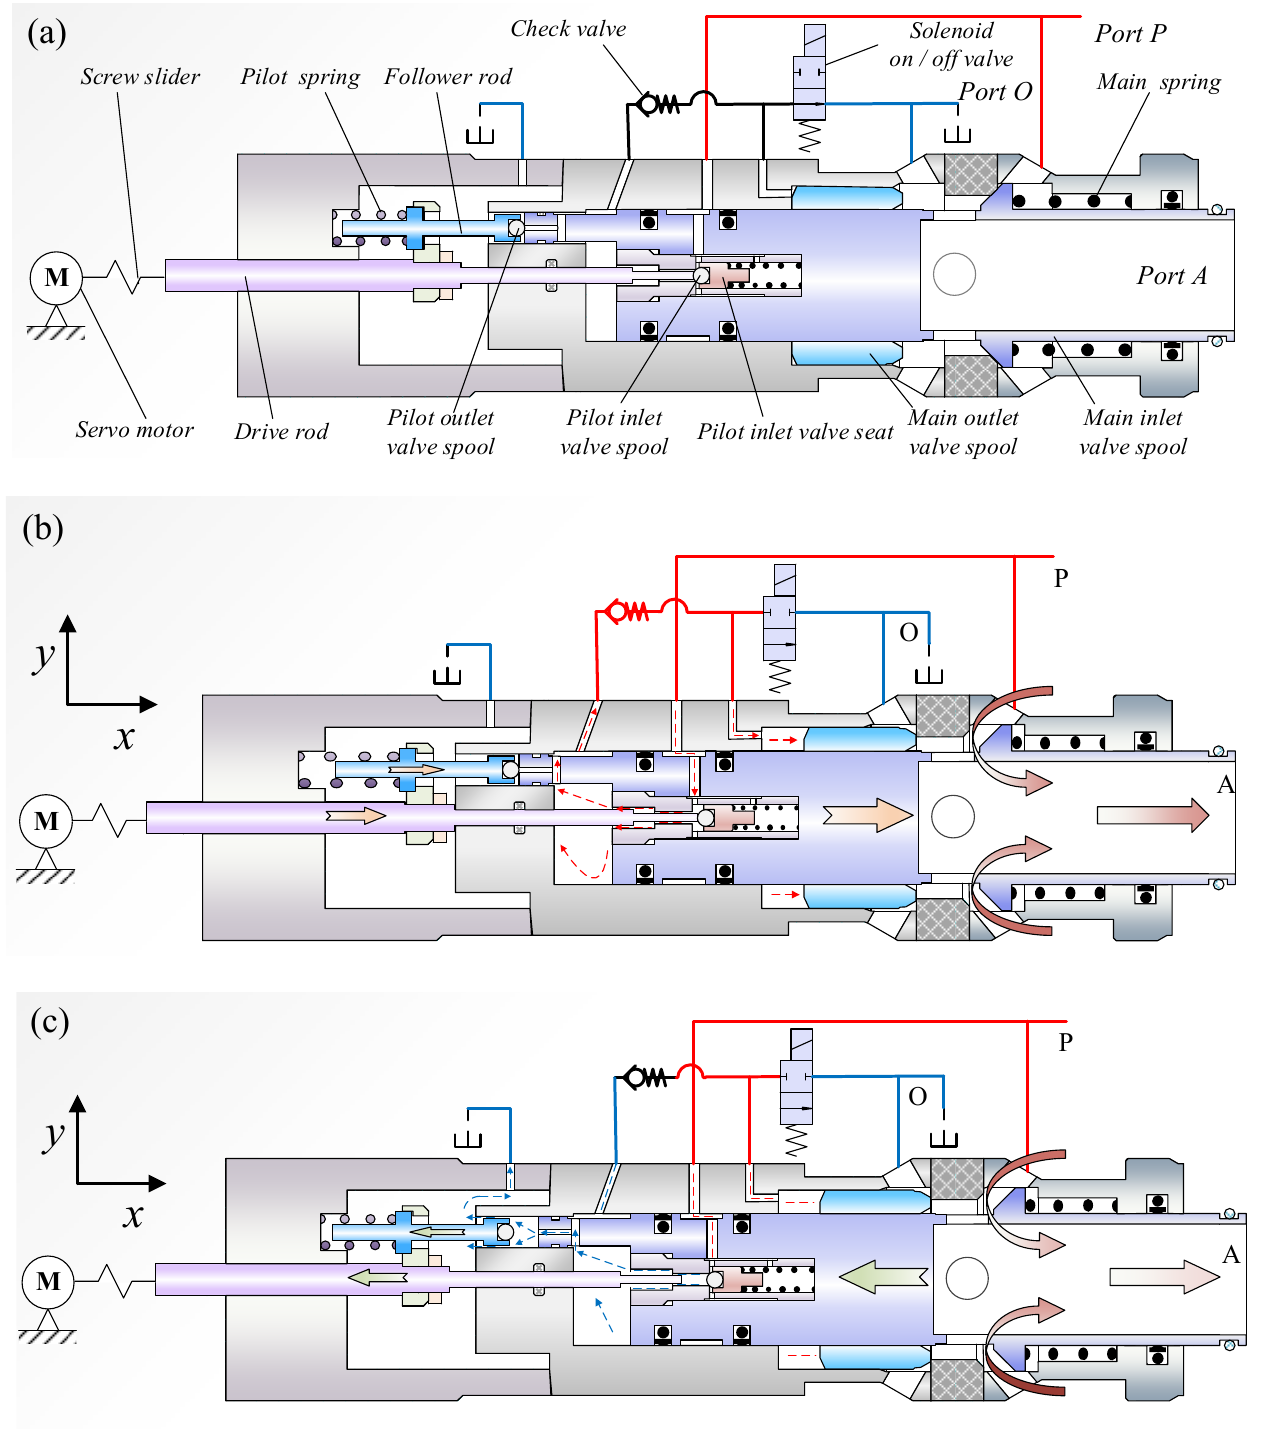
Figure 1. Principle of the water hydraulic proportional directional valve: ( a ) initial state; ( b ) opening process; ( c ) closing process.